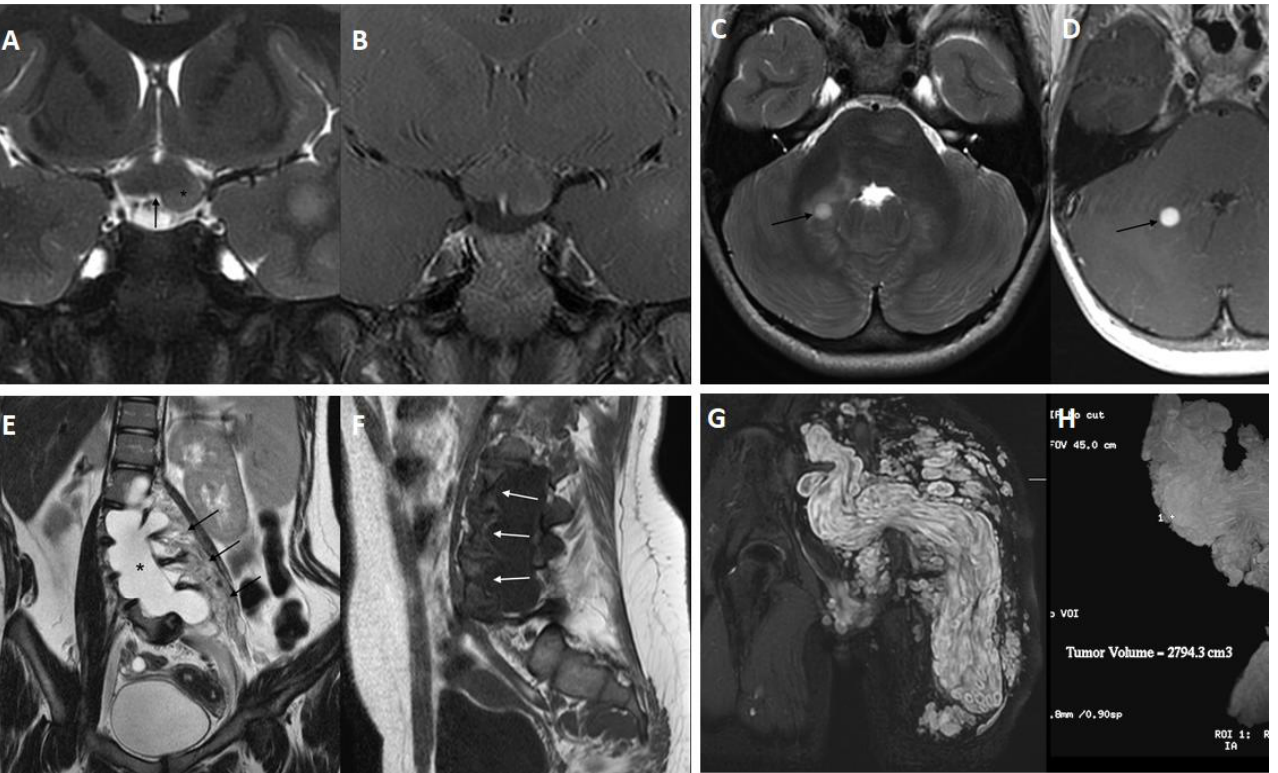
Figure 3. Coronal T2-weighted ( A ) and T1-weighted MR images after fat suppression contrast ( B ) showing a thickened optic chiasm (black arrow) with a lobulated mass-effect lesion (asterisk) on the left showing a hyperintense signal and a linear contrast enhancement. T2 axial TSE sequences ( C , D ) showing a hyperintense rounded focal lesion (black arrow) with minimal marked and homogeneous vasogenic edema (black arrow) in the right middle cerebellar pedicle in line with a likely low-grade lesion. Coronal T2-weighted ( E ) and sagittal T1-weighted ( F ) sequences of lumbosacral spine showing a plexiform neurofibroma (black arrows), marked dural ectasia (asterisk) associated with significant scalloping of the posterior lower lumbar vertebral bodies ( white arrows ). Coronal STIR images with volumetric reconstruction ( G , H ) showing a voluminous plexiform neurofibroma arising from the lumbo-sacral plexus and extending into the left thigh region.